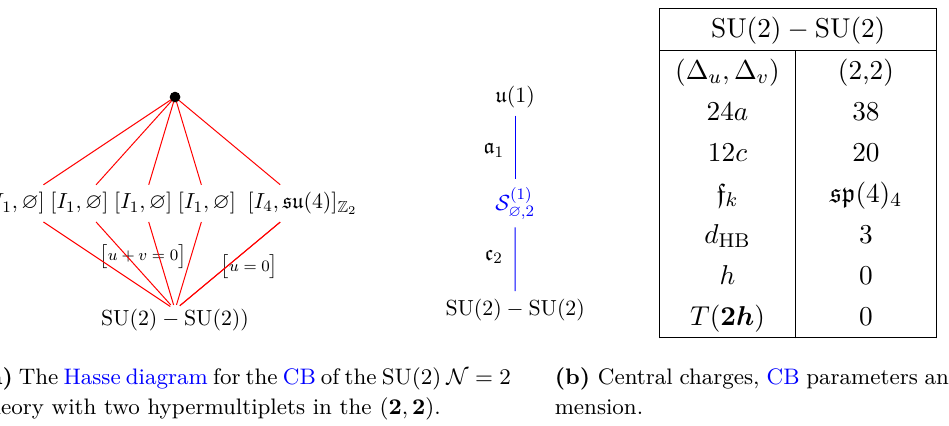
Figure 20. Information about the e T E